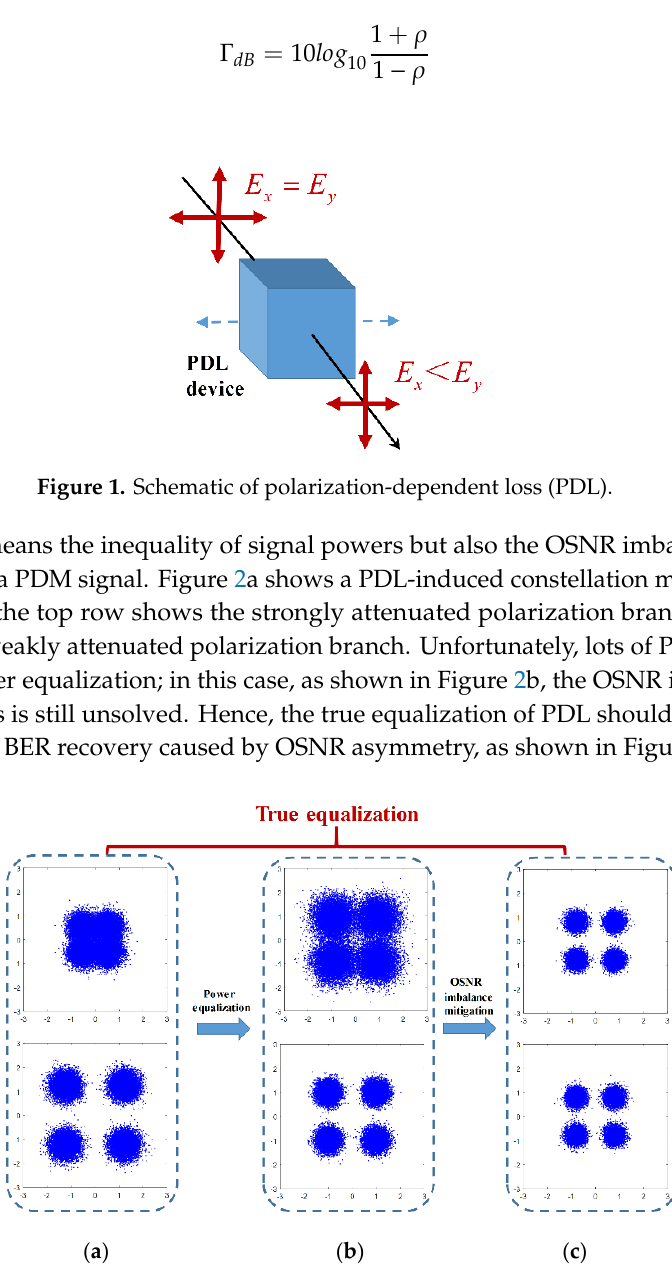
Figure 2. Schematic representation of PDL equalization: ( a ) The signal suffers PDL; ( b ) after power equalization; ( c ) after bit-error-rate (BER) recovery coming from optical signal-to-noise ratio (OSNR) imbalance.